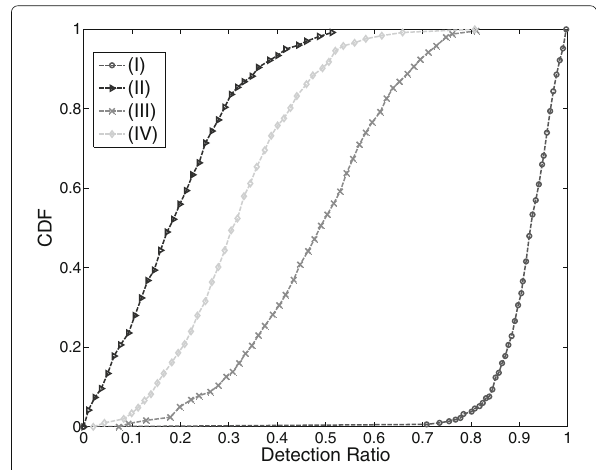
Fig. 6 Numeric simulation results using the single- and multi-watermark detection schemes. Confronting the performance of the two detectors. ( I ) χ 2 detector in [4, 5] and cyber adversary. ( II ) χ 2 detector and non-parametric cyber-physical adversary. ( III ) Multi-watermark detector with switching frequency set to 0.14 Hz and non-parametric cyber-physical adversary. ( IV ) Multi-watermark detector with switching frequency set to 0.05 Hz and non-parametric cyber-physical adversary